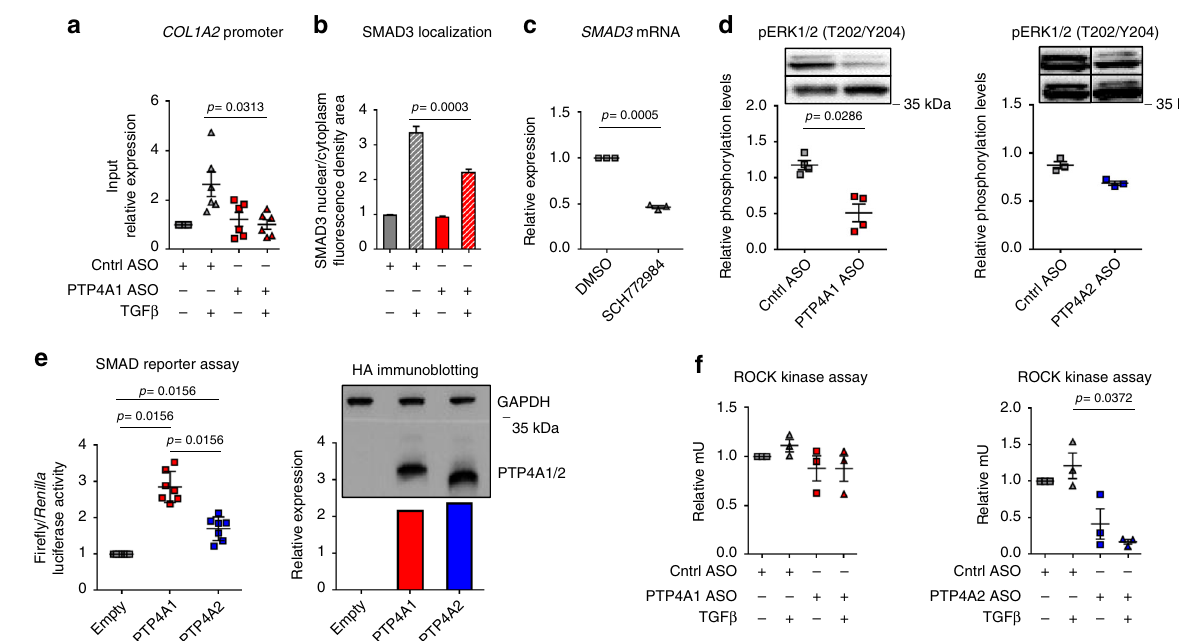
Fig. 5 PTP4A1 in fl uences TGF β pro- fi brotic signaling through SMAD3. a Mean ± SEM of COL1A2 promoter expression in six different NHDF lines treated with PTP4A1 ASO, stimulated with TGF β 1 and normalized to the same lines treated with control ASO. pSMAD3 antibody was used to perform the ChIP. b Mean ± SEM of the ratio between SMAD3 nuclear and cytoplasmatic fl uorescence densitometry in three cell lines treated with control ASO and PTP4A1 ASO and then stimulated with TGF β 1. c Mean ± SEM of SMAD3 mRNA expression measured by qPCR in three NHDF lines treated with 50 μ m SCH772984 ERK inhibitor and normalized to the same lines treated with DMSO. d Mean ± SEM of densitometric scan expression plus representative immunoblotting for pERK1/2 (T202/Y204) (upper bands) normalized to ERK2 (lower bands) in four different NHDF lines treated with control ASO, PTP4A1 ASO (left graph) or PTP4A2 ASO (right graph, three different NHDF lines). Images are from different lanes on the same membrane. e Left graph shows mean ± SEM of relative ratio of fi re fl y/ Renilla luciferase signal of HEK 293T cells co-transfected with human PTP4A1 WT or PTP4A2 WT-encoding HA-tag pCDNA4 vectors together with a fi re fl y luciferase SMAD reporter and a control luciferase Renilla vector. Cells were stimulated with TGF β 1. Graph is representative of 6 independent experiments. Right graph shows densitometric scan relative expression plus representative immunoblotting for HA-tagged PTP4A1/2 (lower bands) normalized to GAPDH (upper bands) in HEK 293T cells co-transfected with human HA-tagged PTP4A1 WT or PTP4A2 WT-encoding pCDNA4. f Mean ± SEM of ROCK kinase activity in three different NHDF lines treated with PTP4A1 (left graph) or PTP4A2 ASO (right graph), stimulated with TGF β 1 and normalized to the same lines treated with control ASO. Wilcoxon test ( a , e left), Mann – Whitney test ( b , d ), or paired t -test ( c , f